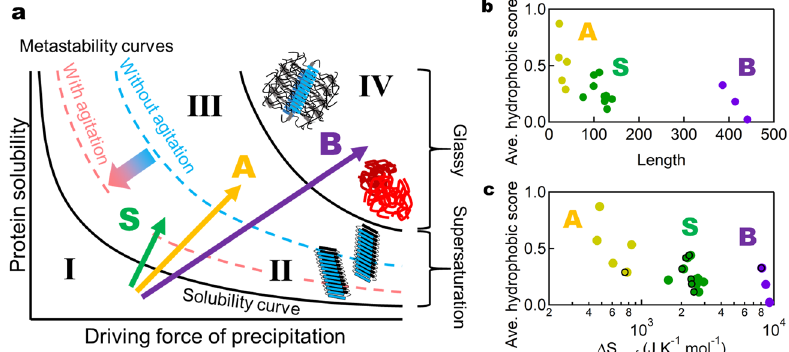
Fig. 5 General schematic conformational phase diagram and the three transitions. Three types of amyloidogenic proteins were plotted on a general phase diagram of aggregation ( a ) and diagrams of average hydrophobicity vs. number of amino acid residues ( b ) or Δ S conf ( c ). In a , an increase in the salt concentration or temperature often increases driving force of precipitation (abscissa), thus decreasing protein solubility (ordinate). In c , Δ S conf represents an increase upon denaturation of the main-chain with (points with frame) and without (points without frame) the contribution of disul fi de bonds (Table